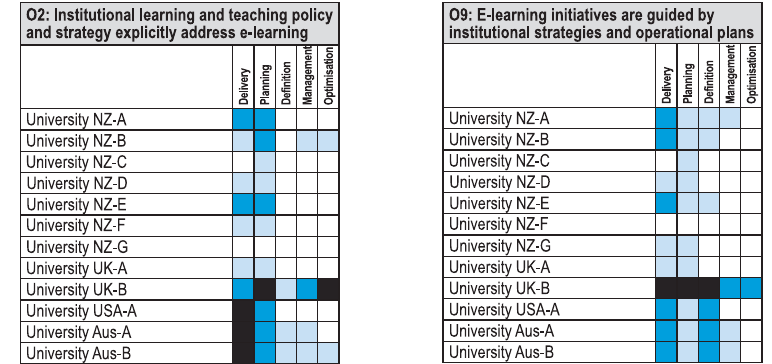
Figure 6. University process O2 and O9 capabilities (Marshall 2009).